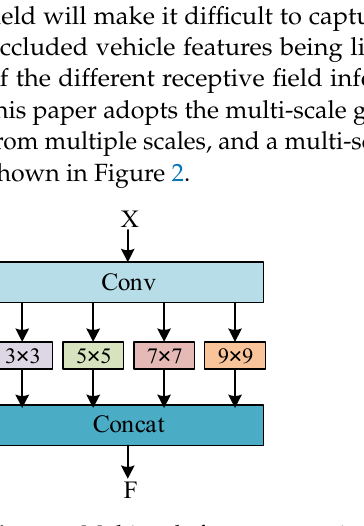
Figure 2. Multi-scale feature extraction module.